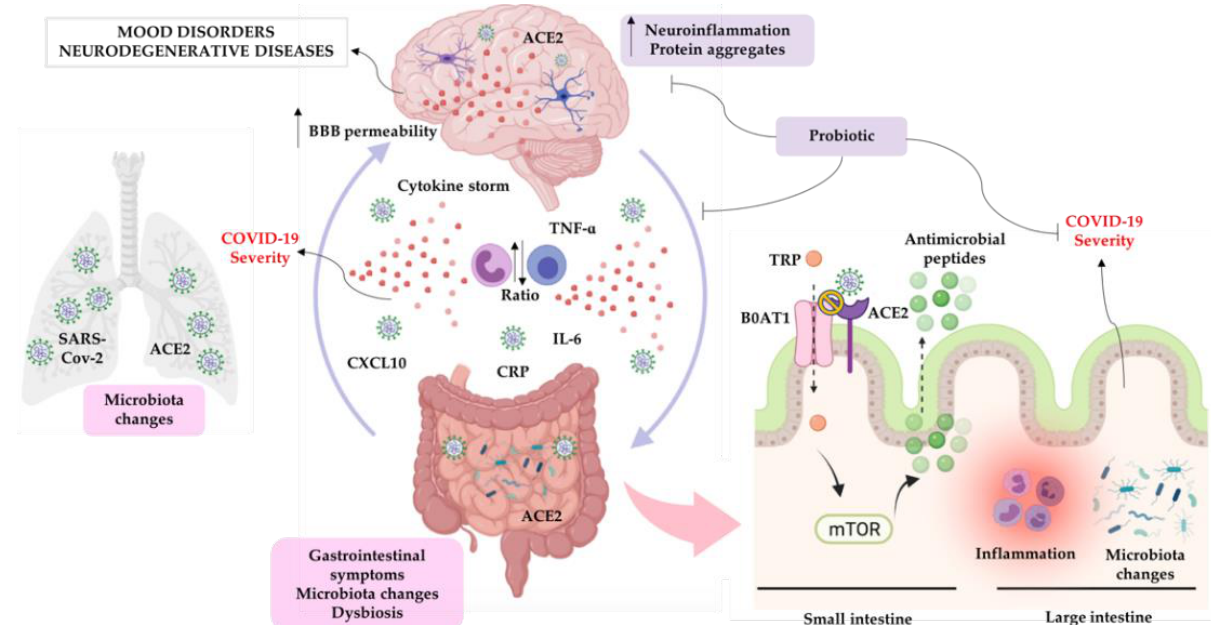
Figure 1. Possible mechanisms involved with microbiota changes and neuropsychiatric conditions in COVID-19. Individuals affected by SARS-Cov-2 have changes in lung microbiota, as well as changes in the gut microbiota, dysbiosis, and gastrointestinal symptoms. SARS-Cov-2 enters the respiratory system and systemic circulation but can also access other organs and systems, including gastrointestinal and central nervous systems. The main mechanism of entry of the virus into cells is mediated by the angiotensin-converting enzyme 2 (ACE-2) receptor, which is widely expressed in these systems. The virus itself is not the only factor associated with the COVID-19 severity; it is believed that elevated inflammatory markers, such as chemokine (C-X-C motif) ligand-10 (CXCL-10), interleukin-6 (IL-6), tumor necrosis factor-alpha (TNF- α ), and C-reactive protein (CRP) and increased neutrophil-to-lymphocyte rate are also involved in disease severity. Systemic exacerbated inflammation could lead to an increase in blood–brain-barrier (BBB) permeability, leading to neuroinflammation. In addition, the virus can also activate microglia cells, leading to increased cytokines release and astrocyte activation, which are associated with the development and progression of mood disorders, including depression. These effects also can elevate protein aggregates that are involved in the pathophysiology of neurodegenerative diseases, such as Parkinson’s and Alzheimer’s diseases. In the small intestine, ACE-2 receptor is necessary for the surface expression of the neutral amino acid transporter B 0 AT1 (SLC6A19). Tryptophan (TRP) is mainly absorbed via the B 0 AT1/ACE2 transport pathway and induces the activation of the mammalian target of the rapamycin (mTOR) pathway, which regulates the expression of antimicrobial peptides, which are important to maintain an ideal microbiota in the large intestine. Thus, the block of this pathway by SARS-CoV-2 binding in the ACE-2 receptor could lead to inflammation and microbiota changes, which can be associated with the COVID-19 severity. There is bidirectional communication between brain and gut; thus, dysbiosis and exacerbated inflammation induced by COVID-19 could affect the brain and increase the risk of mood disorders and neurodegenerative diseases. Probiotic treatment could be an alternative treatment since it can reduce inflammation and improve gut microbiota. Images were extracted from Biorender